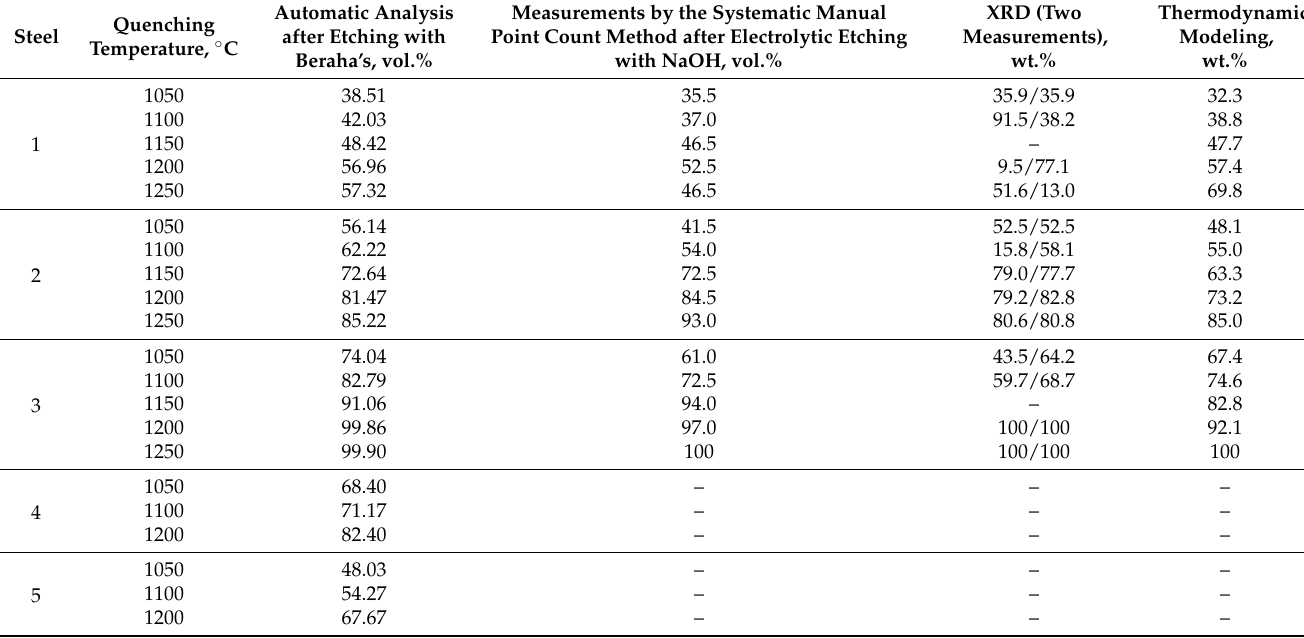
Table 3. Comparison of methods for assessing the fraction of phase components by the example of δ -ferrite. Automatic Analysis Measurements by the Systematic Manual Quenching after Etching with Point Count Method after Electrolytic Etching Steel Temperature, ◦ C Beraha’s, vol.% with NaOH,